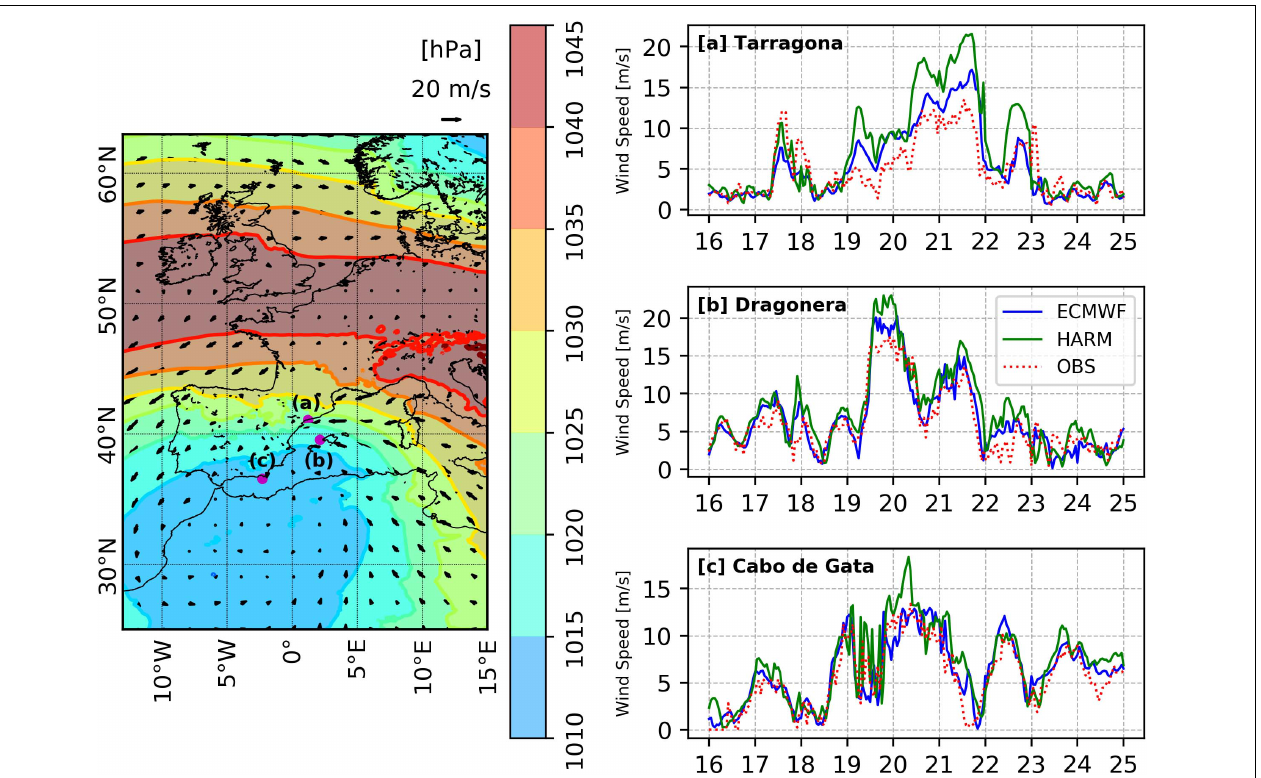
FIGURE 1 | (left) Daily-averaged mean sea-level pressure (MSLP) and surface wind fields at Western Europe, during the storm peak (2020/01/21). The colored areas denote the MSLP and the black arrows the 10 m-wind fields. Data source: ECMWF IFS forecast model. (right) Timeseries of 10-m wind observed (red dots) and forecasted by AEMET HARMONIE 2.5 (green solid line) and ECMWF IFS systems (green blue line). Series taken at the PdE Tarragona tidal station [a] , the PdE Dragonera mooring buoy [b] and the Cabo de Gata one [c] .